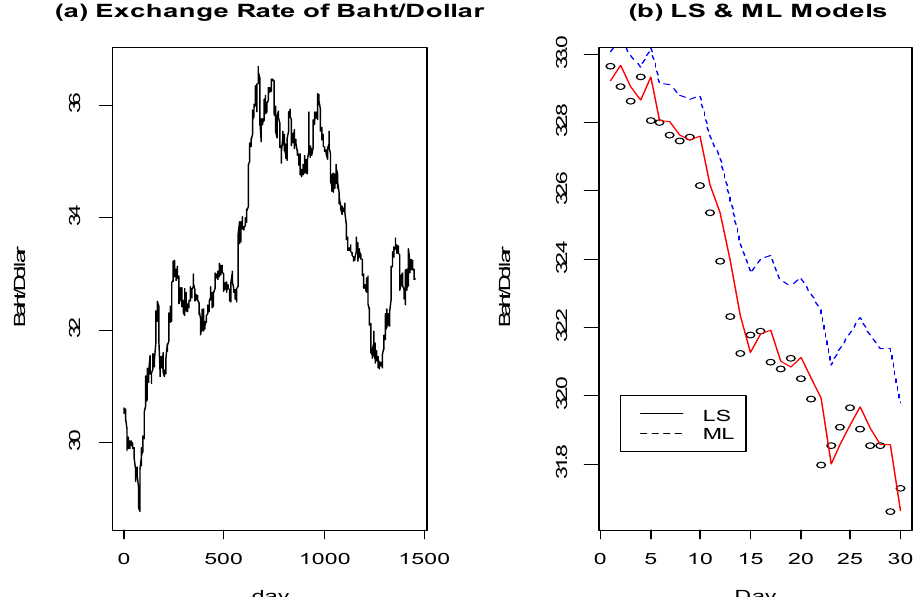
Figure 13. The time series plot for the exchange rate of Baht/Dollar, and the plot of the exchange rate of Baht/Dollar for forecasting of least squares (LS) vs. maximum likelihood methods.